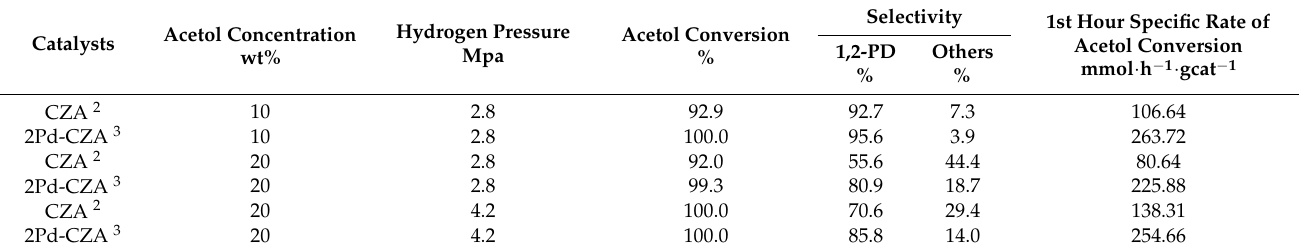
Table 3. Promoting effect of Pd on CZA catalysts for acetol hydrogenation 1 .